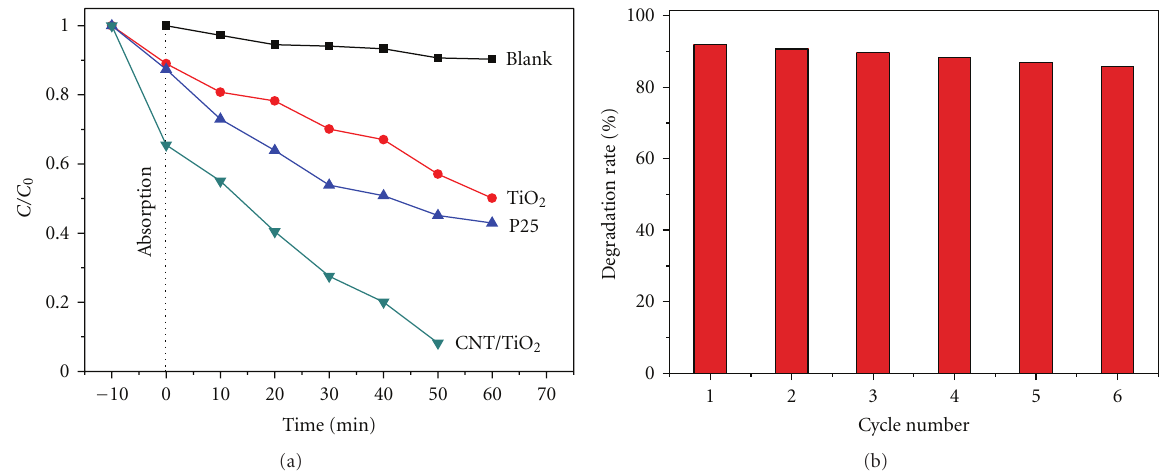
Figure 4: (a) The photocatalytic degradation of RhB in the absence of any photocatalysts (the blank test) and in the presence of di ff erent photocatalysts. (b) 6 cycles of degradation of RhB using CNT/TiO 2 nanohybrids as the